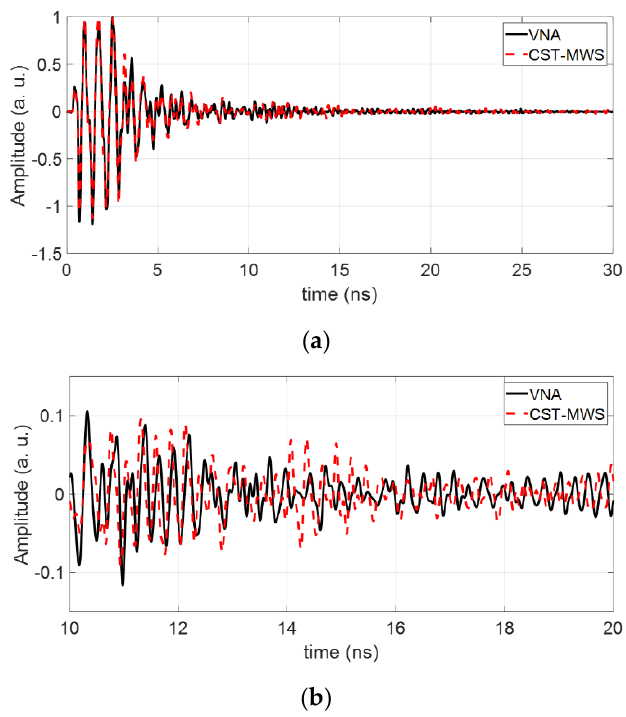
Figure 7. Time-domain sensor signal obtained by way of the frequency domain measurement of the scattering parameter S 21 using the VNA (black solid curve) and the full-wave CST MWS software (red, dashed line) ( a ) in the 030 ns time interval and ( b ) in the 1020 ns interval.